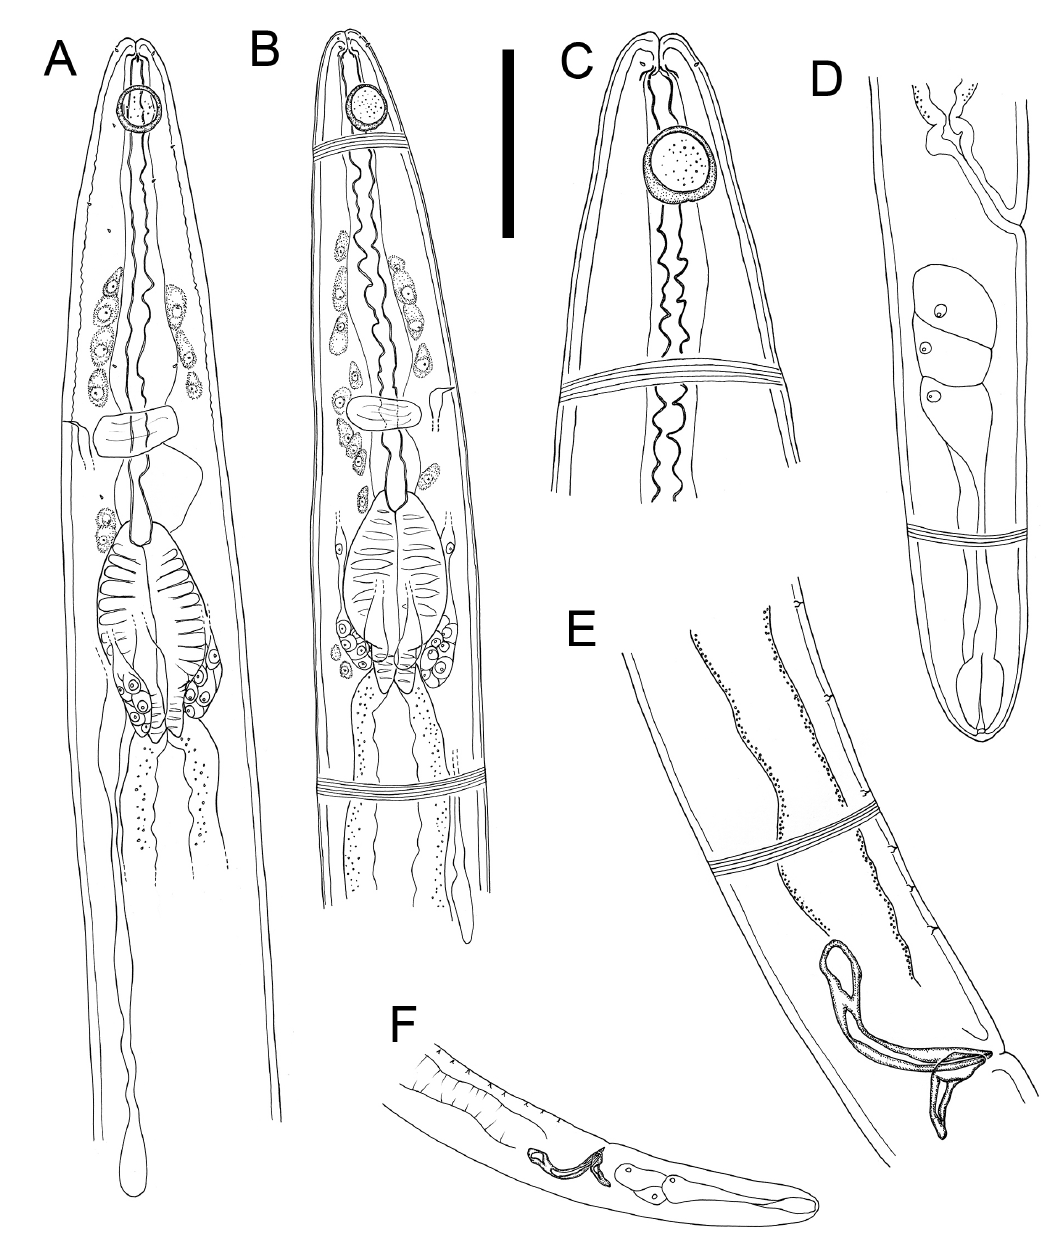
Fig. 13. Aegialoalaimus magnus sp. nov. A – B , D . Paratype (NIWA154920). C , E – F . Holotype (NIWA 154918). A – B . Female anterior body region. C . Male cephalic region. D . Female posterior body region. E . Male copulatory apparatus. F . Male posterior body region. Scale bar: A–B = 100 µm; C = 60 µm; D–E = 50 µm; F = 125